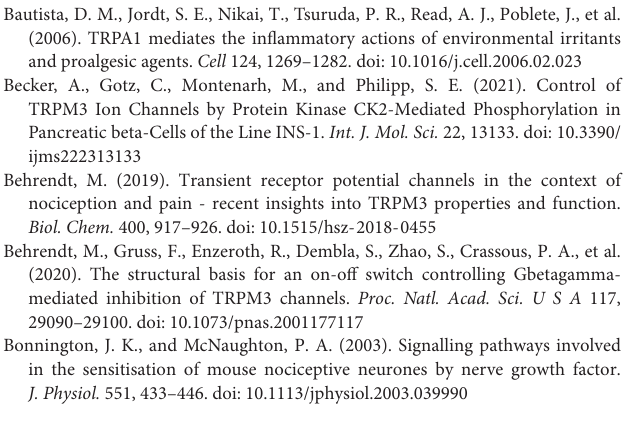
Supplementary Figure 1 | BK-induced calcium response amplitudes. The amplitude of BK-induced calcium responses in the presence of all the substances used throughout the study. Scatter dot plot (black and gray) with mean and standard error